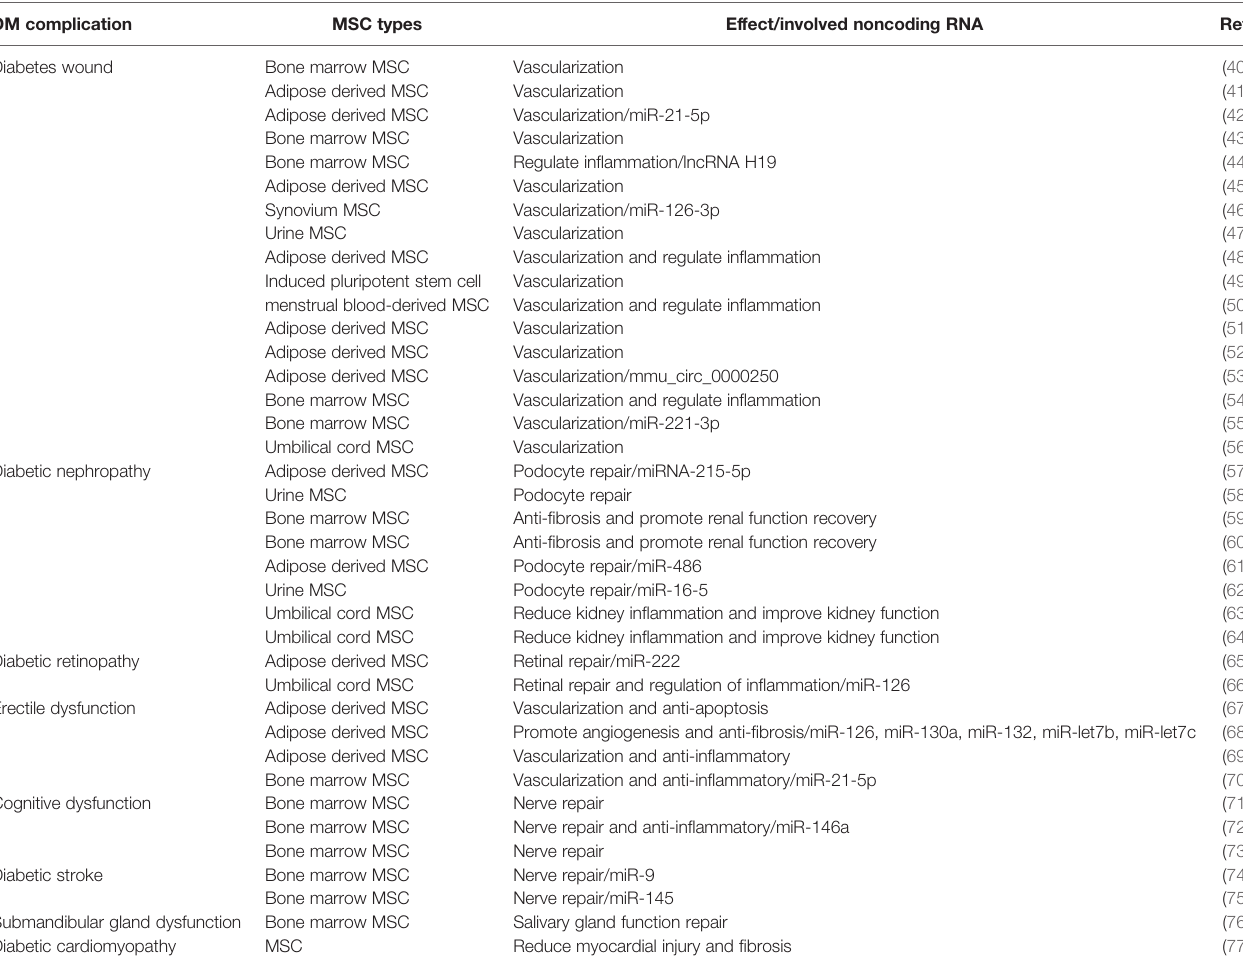
TABLE 2 | MSC used in the treatment of DM